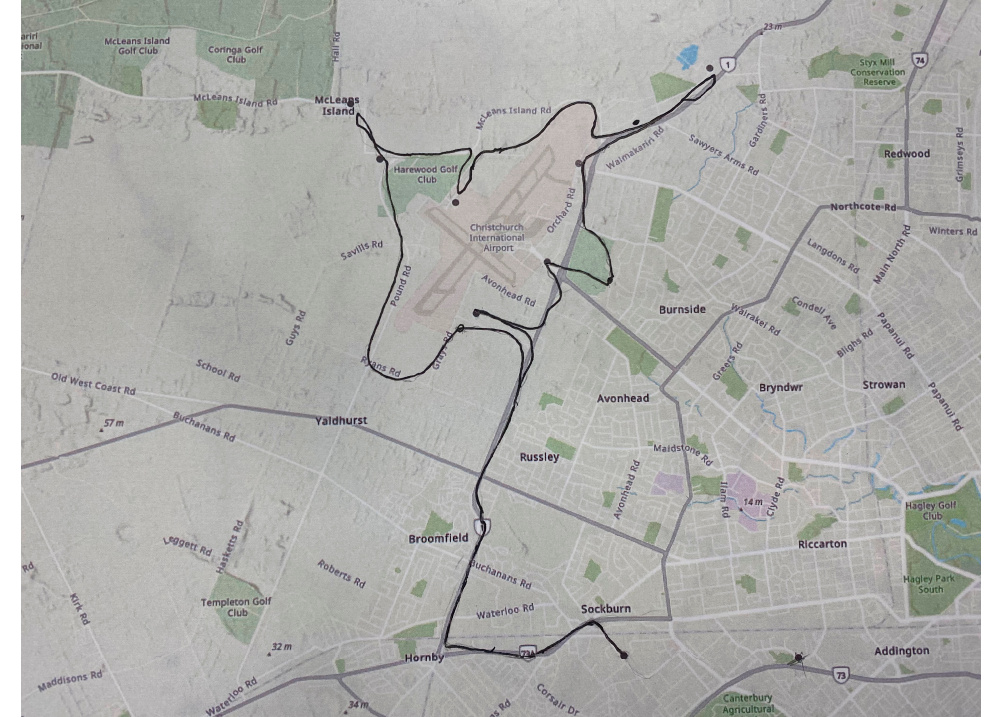
Figure 8. Delivery route deduced by the driver.